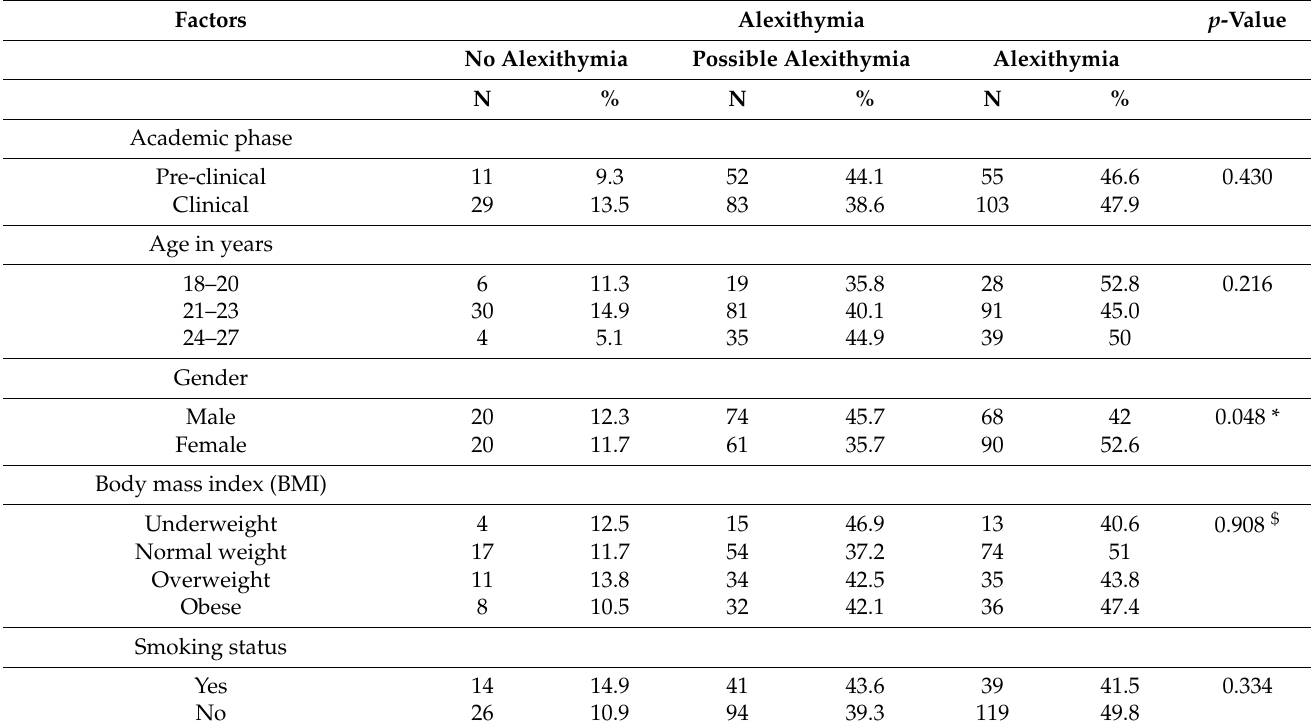
Table 3. Factors associated with Alexithymia among medical students at King Khalid University, Saudi Arabia,